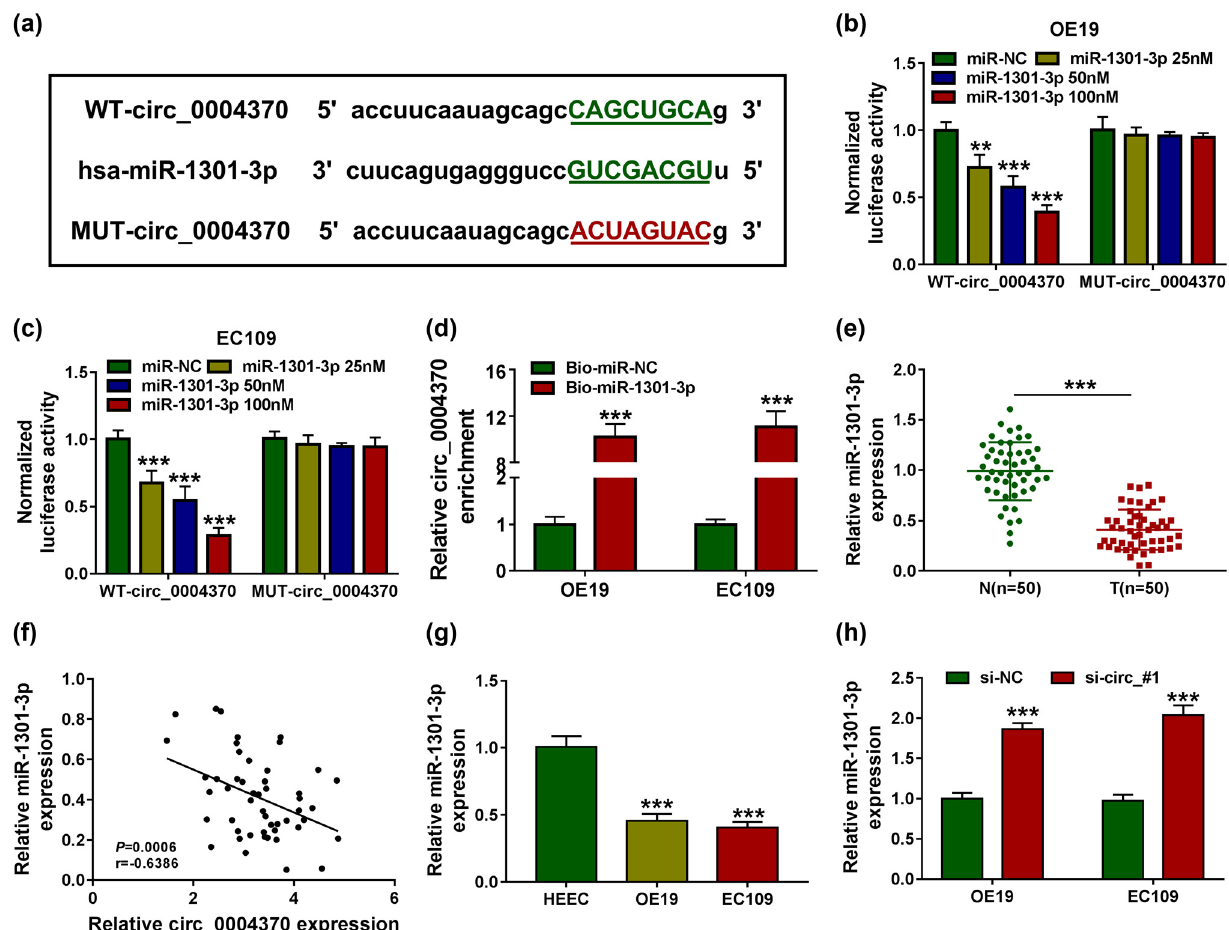
Figure 3: MiR - 1301 - 3p was a direct target of circ_0004370. ( a ) The binding site of circ_0004370 and miR - 145 - 5p was measured by starBase v2.0. ( b – d ) The interaction between miR - 1301 - 3p and circ_0004370 in OE19 and EC109 cells was determined by dual - luciferase reporter assay and RNA pull - down assays in OE19 and EC109 cells. ( e ) Relative miR - 1301 - 3p expression in EC tissues and in adjacent normal tissues was measured by RT - qPCR. ( f ) The correlation between miR - 1301 - 3p and circ_0004370 levels was measured. ( g ) Relative miR - 1301 - 3p expression in OE19, EC109, and HEEC cells was detected by RT - qPCR. ( h ) After transfecting si - NC or si - circ_#1, the expression level of miR - 1301 - 3p was detected by RT - qPCR. *** P <